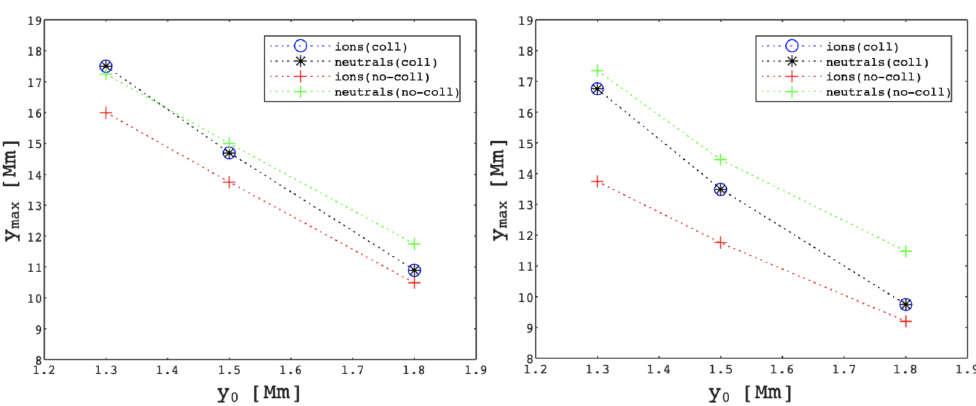
Figure 5. Maximum heights, y max , of Jet1, Jet2, and Jet3 versus the corresponding vertical position of the initial velocity pulse in y 0 for A v = 100 km/s for the cases of the uniform ( left ) and flux tube ( right ) magnetic filelds. Here, the open circle represents ion jets with S in (cid:54) = 0; the asterisks represents neutral jets with S in (cid:54) = 0; the red plus symbol represents ion jets with S in = 0; and the green plus symbol represents neutral jets with S in = 0. See text for